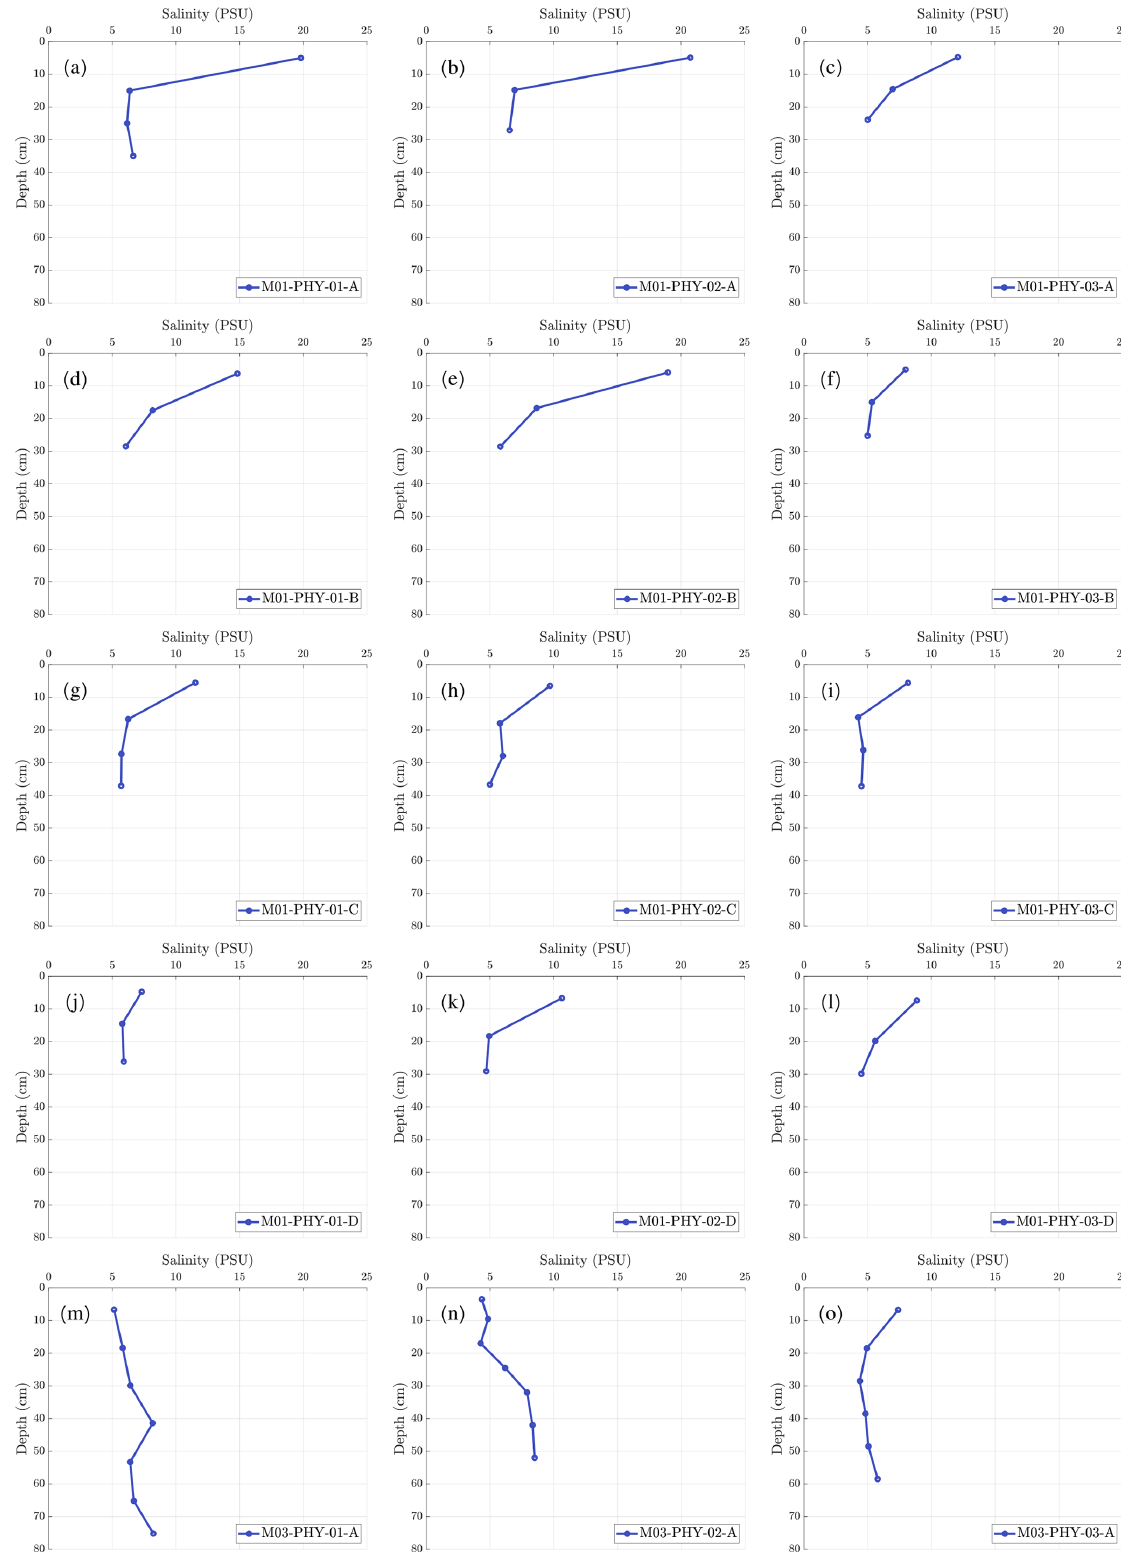
Figure 7. Plots of salinity over sea ice depth for the four pancake ice floes (cores M01-PHY-01-A, M01-PHY-01-B, M01-PHY-01-C, M01- PHY-01-D, M01-PHY-02-A, M01-PHY-02-B, M01-PHY-02-C, M01-PHY-02-D, M01-PHY-03-A, M01-PHY-03-B, M01-PHY-03-C, M01- PHY-03-D) and for the consolidated pack ice (cores M03-PHY-01-A, M03-PHY-02-A and M03-PHY-03-A). The Cryosphere, 16, 2899–2925, 2022